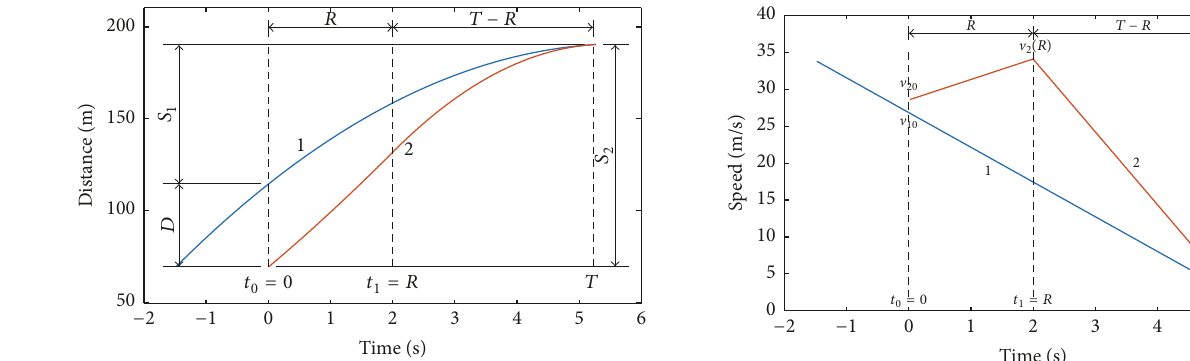
Figure 2: Speed-time profile for the conflict situation. The profiles are numbered with 1 and 2 for the leading and following vehicles, respectively, while V 10 and V 20 are the corresponding initial